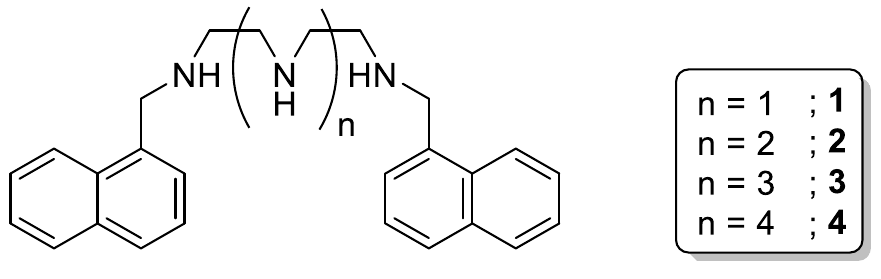
Figure 1. Scheme of the recognition of an analyte by blocking the PET process. Figure adapted from reference [1].